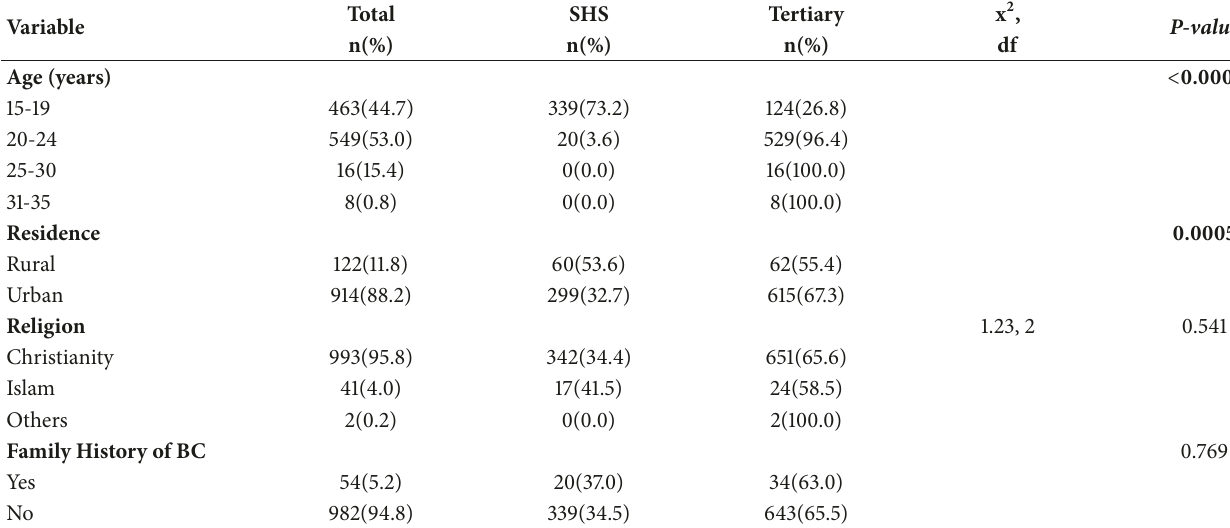
Table 1: Sociodemographics of study participants stratified by their educational